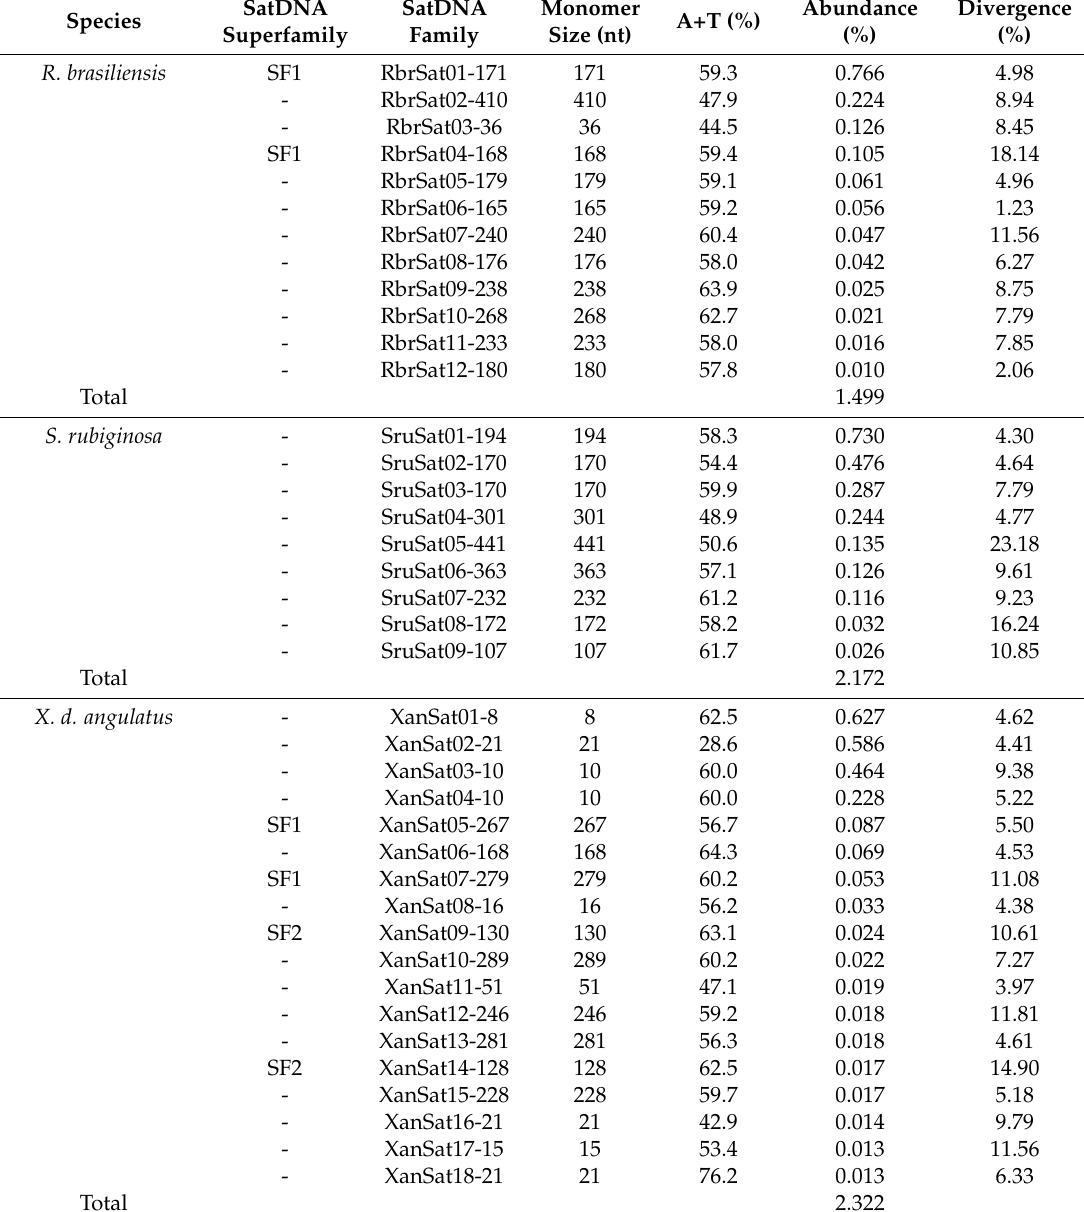
Table 1. Characteristics of satellite DNA (satDNA) families isolated from the genomes of three grasshopper species, including their monomer sizes, base pair richness, and genome